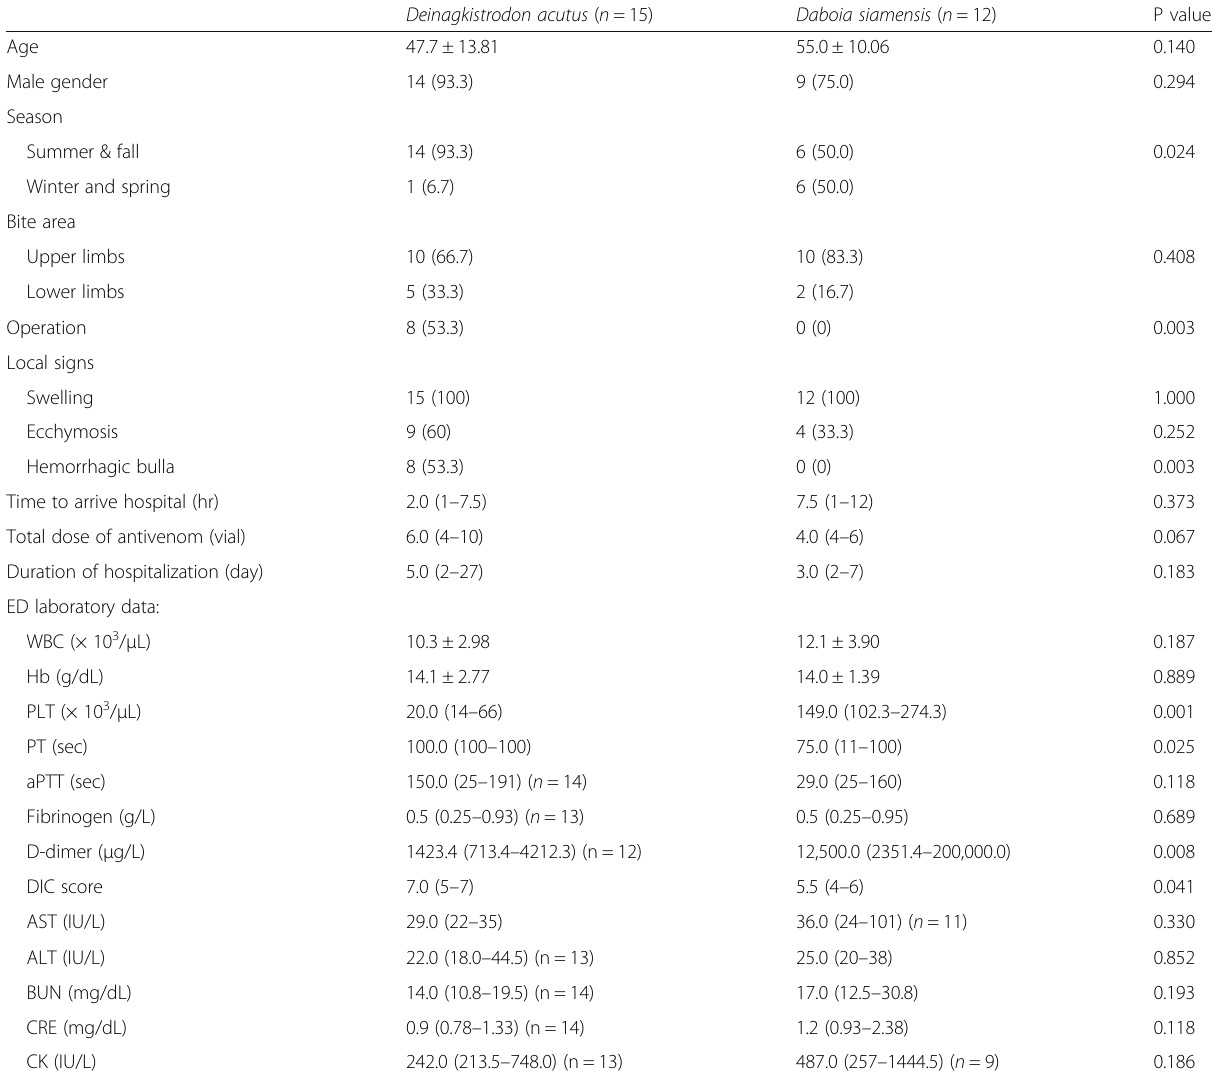
Table 1 Comparison of clinical and laboratory characteristics between patients with Deinagkistrodon acutus and Daboia siamensis